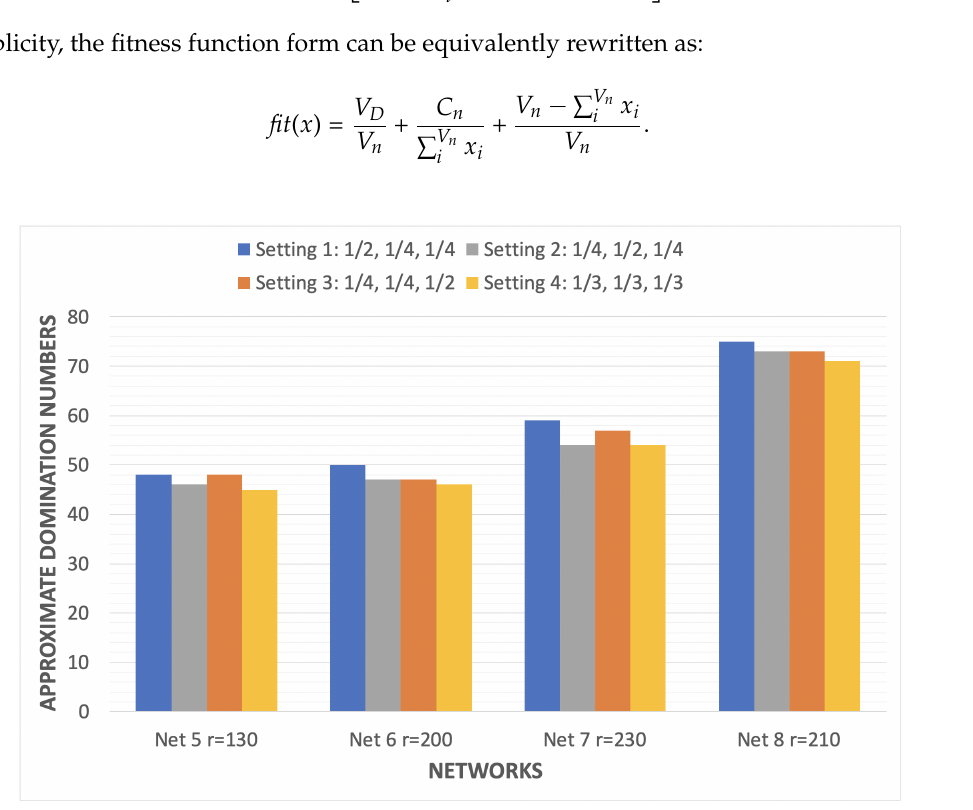
Figure 6. The performance of the different settings of the fitness function